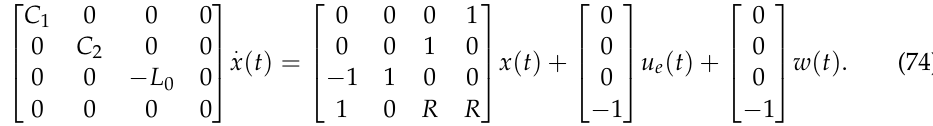
Figure 4. Filtering error variances of local filters with and without feedback for sensor 1. ( a ) The first